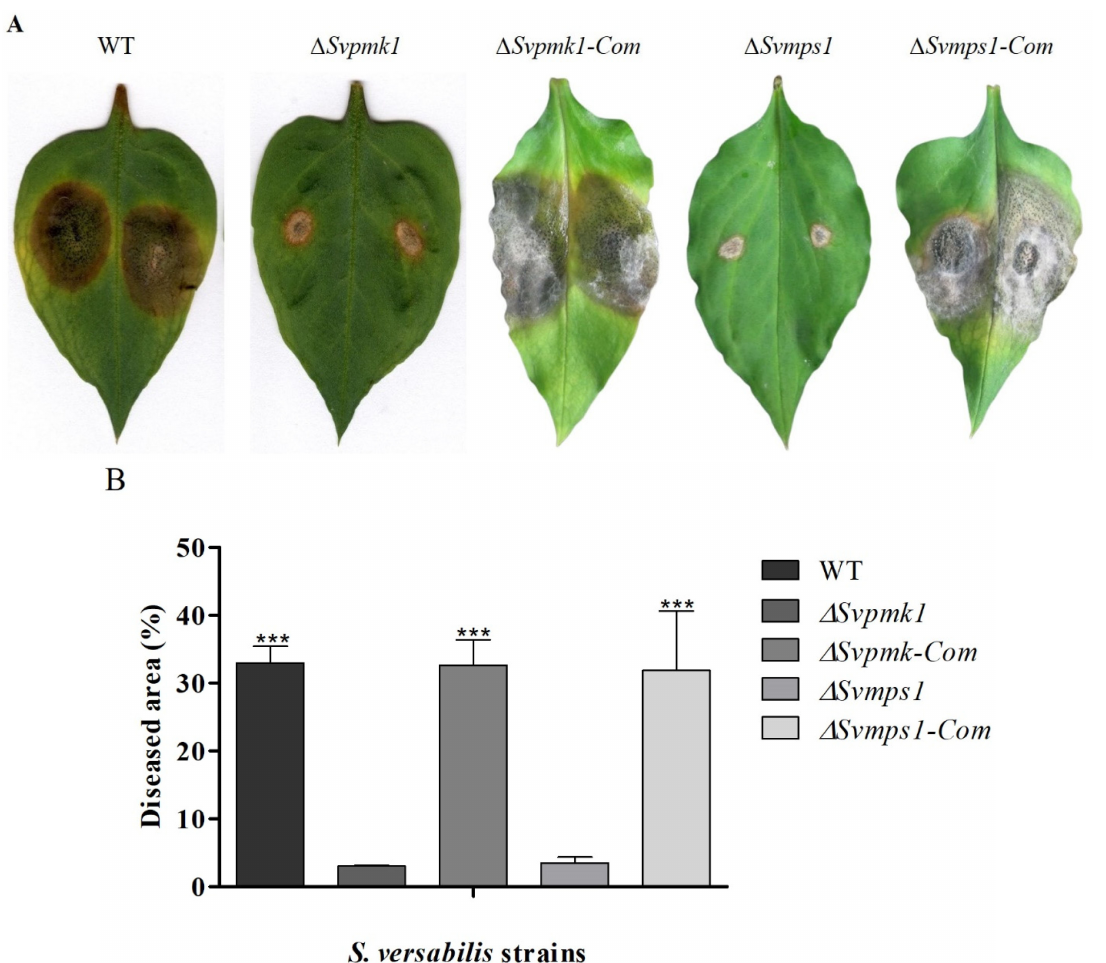
Figure 6. Roles of SvPmk1 and SvMps1 on pathogenicity of S. versabilis . ( A ) Disease symptoms on wounded detached leaves of P. heterophylla inoculated with mycelial plugs from WT, ∆ Svpmk1